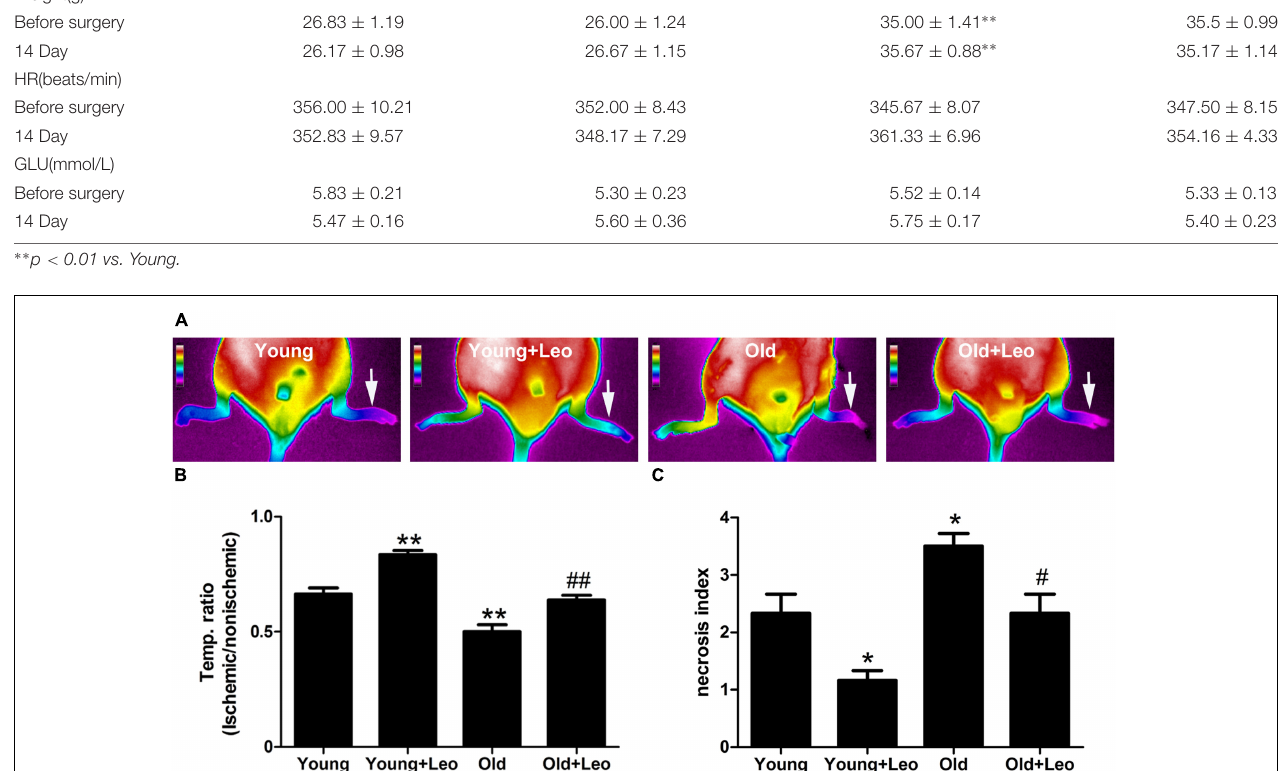
FIGURE 2 | Effects of aging and leonurine on blood flow recuperation. Hindlimb perfusion was measured with TIRI analyzer and expressed by the ischemic/non-ischemic limb temperature ratios. (A) Representative results of TIRI measurements 14 days after hindlimb ischemia operation in different groups of mice. A color scale represents blood flow variations from minimal (dark blue) to maximal (white) values. Arrows indicate ischemic (left) hindlimb. (B) Quantification of Reperfusion values represented by changes in ischemic/non-ischemic limb perfusion. (C) Necrosis scores evaluated on day 14. Values are expressed as mean ± SEM. ∗ p < 0.05 vs. young group; ∗∗ p < 0.01 vs. young group; # p < 0.05 vs. old group; ## p < 0.01 vs. old group. n = 10 for each